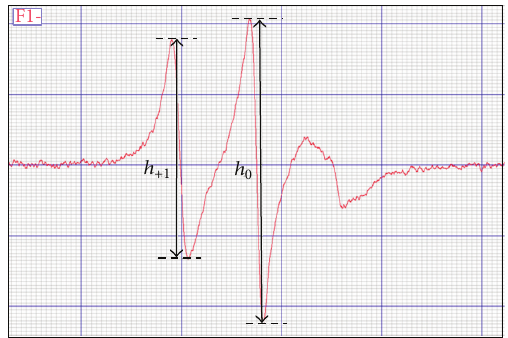
Figure3:ESRspectrumoferythrocyteslabeledwith16-doxylstearic acid. Measurement parameters: center field: 3473 G, frequency: 9.74 GHz, microwave power: 10 mW, and sweep width: 100 G.